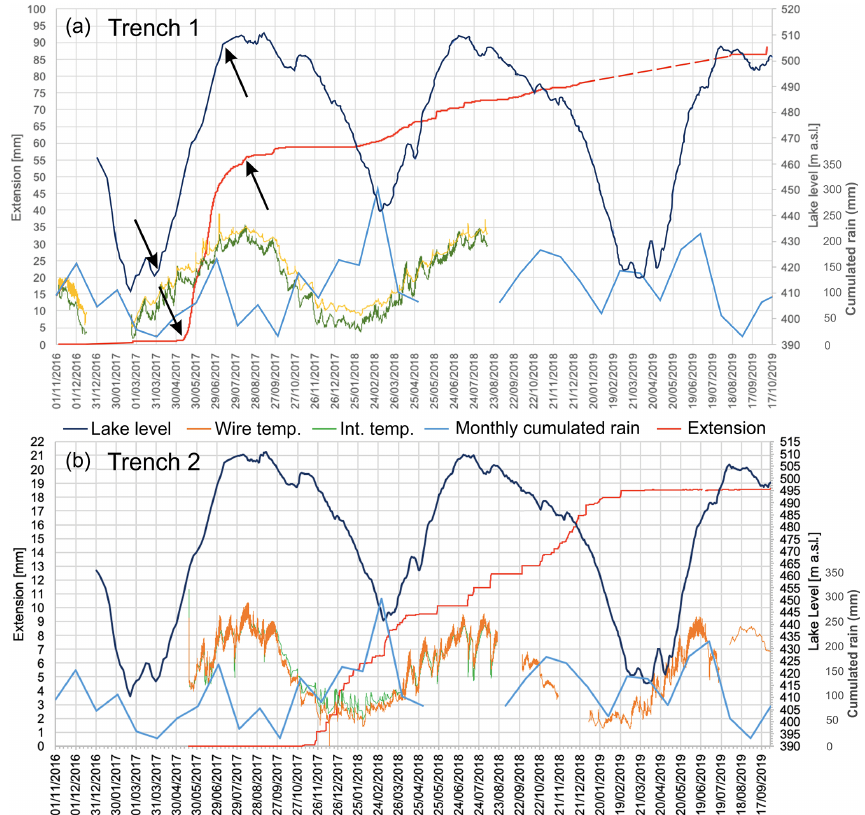
Figure 11. Graphs showing the combination of all data collected at Trench 1 (a) and Trench 2 (b) . Note that rainfall is expressed as cumulated monthly precipitation. The arrows point to the segments of the extension and lake level curves that show similar shapes with a short lag.